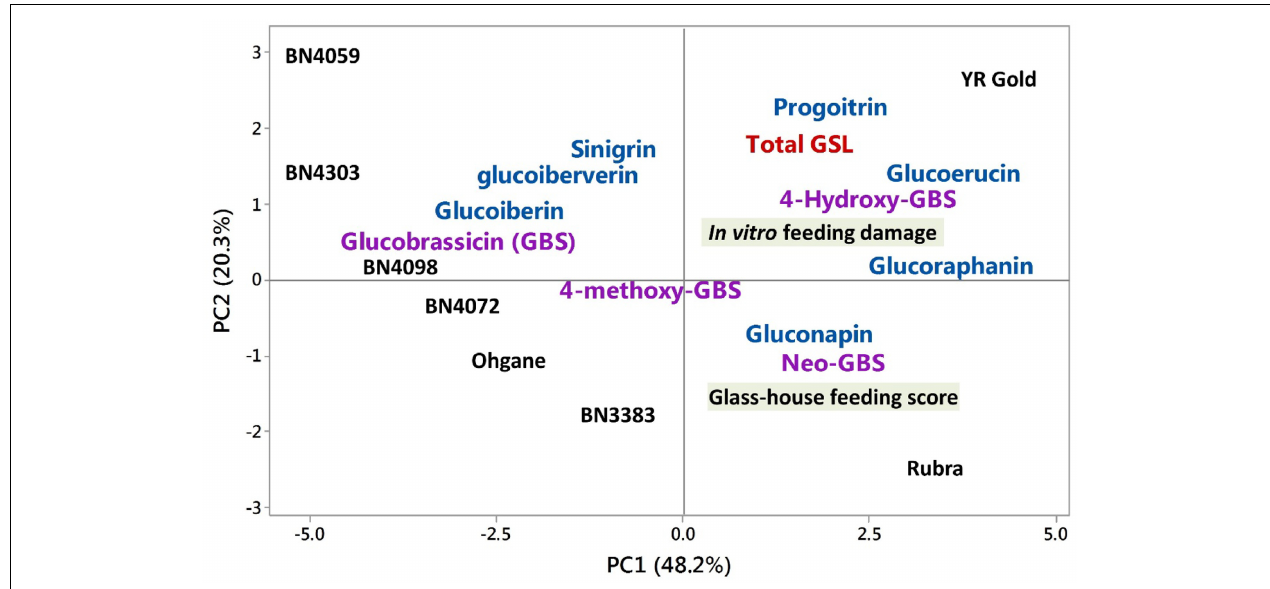
FIGURE 7 | Biplot of glucosinolate contents in eight cabbage genotypes and insect feeding responses as determined by the principle component analysis (PCA). Black letters denote mean PC scores of each cabbage line. Blue and violet colors represent co-efficients between PC1 and PC2 for aliphatic and indolic glucosinolates, respectively. GBS, glucobrassicin; GSL, glucosinolate. Rubra, YR gold, and Ohgane are commercial cabbage cultivars. The other three genotypes with ‘BN’ prefixes are the cabbage inbred lines. In vitro and glass-house feeding scores indicate the insects’ preference to cabbage